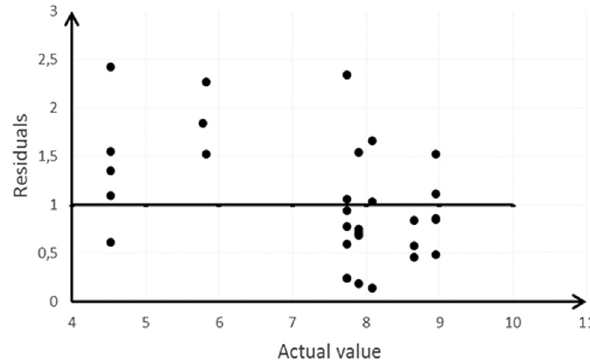
Figure 6: Residuals ( calculated minus actual ) versus actual values of FFA for low - priced, fairly average priced and premium - priced cat